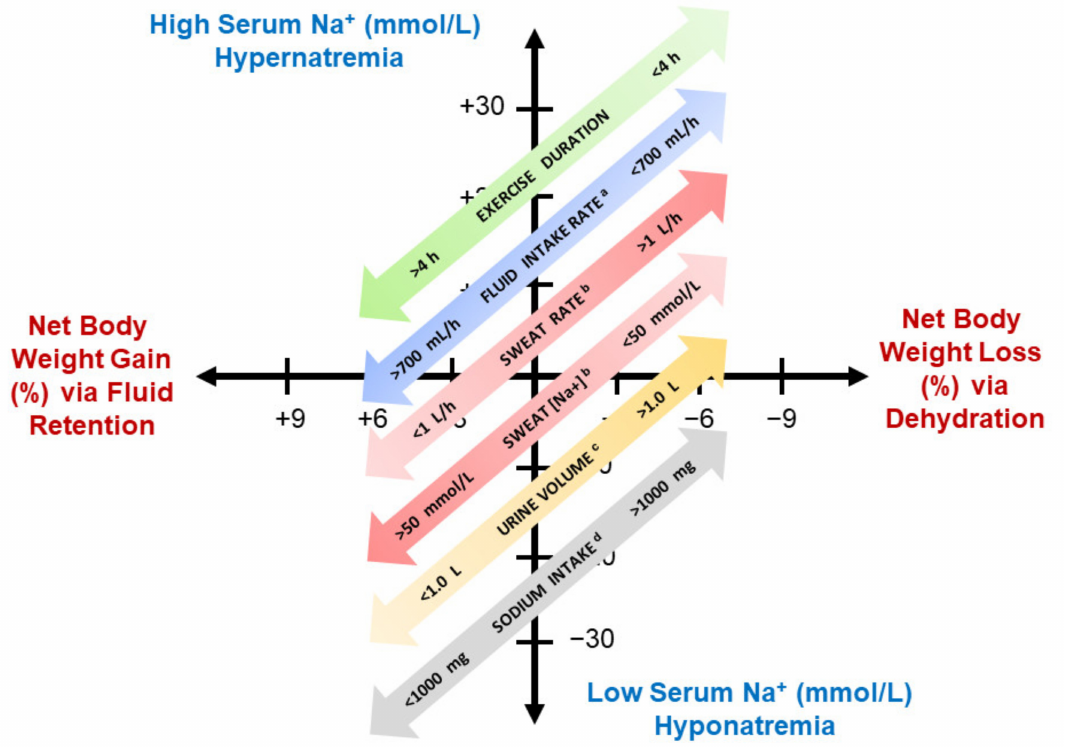
Figure 6. Factors that influence the relationship between body weight gain/loss and serum Na + during endurance exercise. The largest effects on whole body fluid–electrolyte balance are the volume of sweat lost and the volume of fluid consumed. Notes: a , water and low-sodium fluids promote dilution of body fluids; b , physical training and heat acclimatization increase sweat rate and decrease sweat sodium concentration; c , urine production decreases during exercise; d , increased dietary sodium encourages water retention but affects only a minor increase of serum Na +